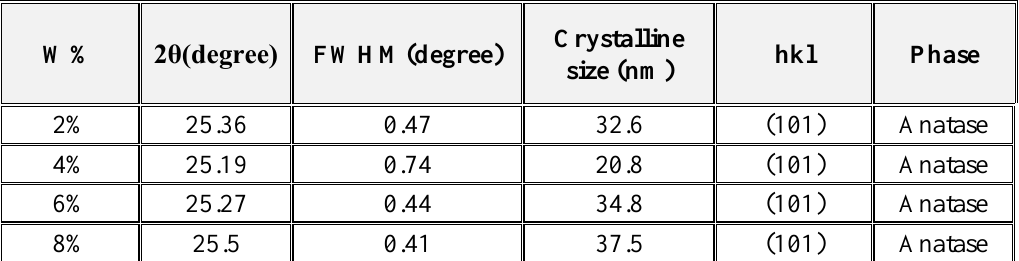
Table 1: Experimental X-ray peaks for (Cr- doped TiO